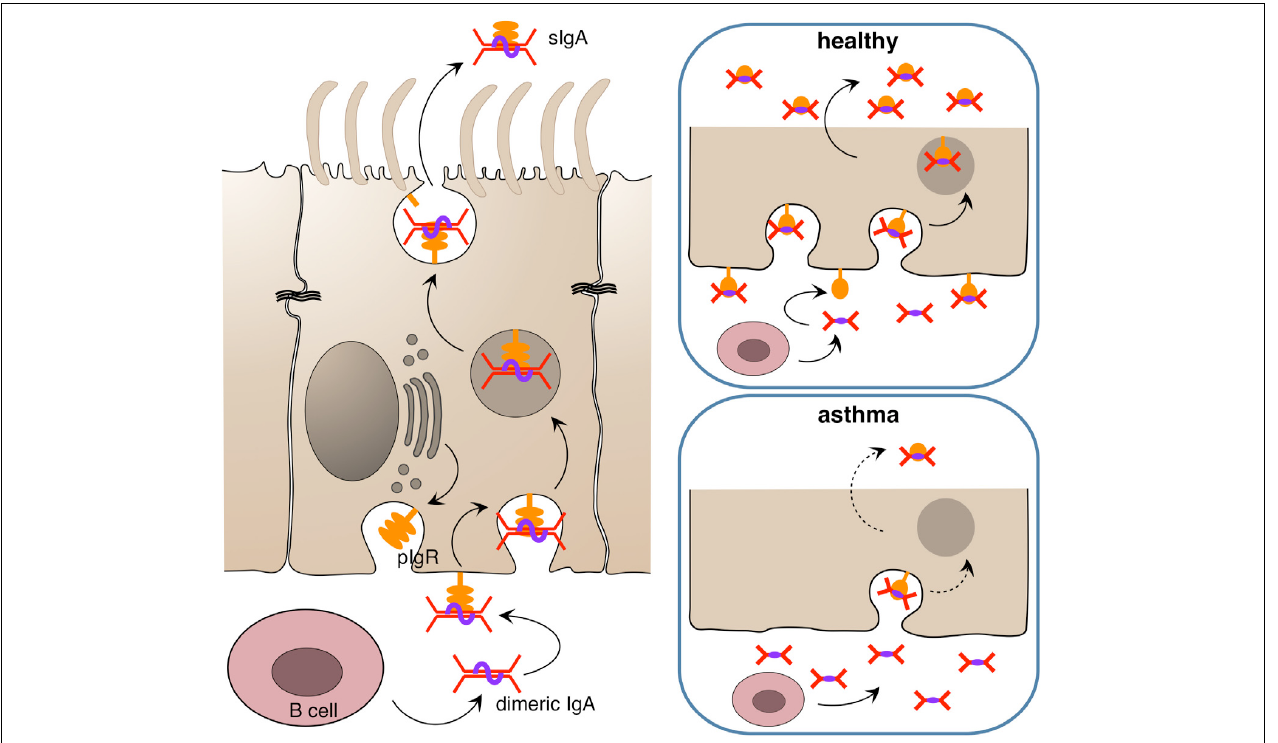
FIGURE 2 | Release of immunoglobulin A at epithelial surfaces. Dimeric IgA is released submucosally by B cells and binds to the poly Ig receptor (pIgR) which is found in high amounts in the basolateral membrane of the epithelium in the healthy state. The complex of pIgR and dimeric IgA is transported in secretory vesicles to the apical side, where it is released into the lumen as secreted IgA (sIgA) to bind target antigens/allergens/pathogens and entrap them in mucus. In the asthmatic state, the amount of pIgR in the epithelium appears to be reduced, resulting in diminished secretion of sIgA and futile accumulation of IgA in the subepithelial